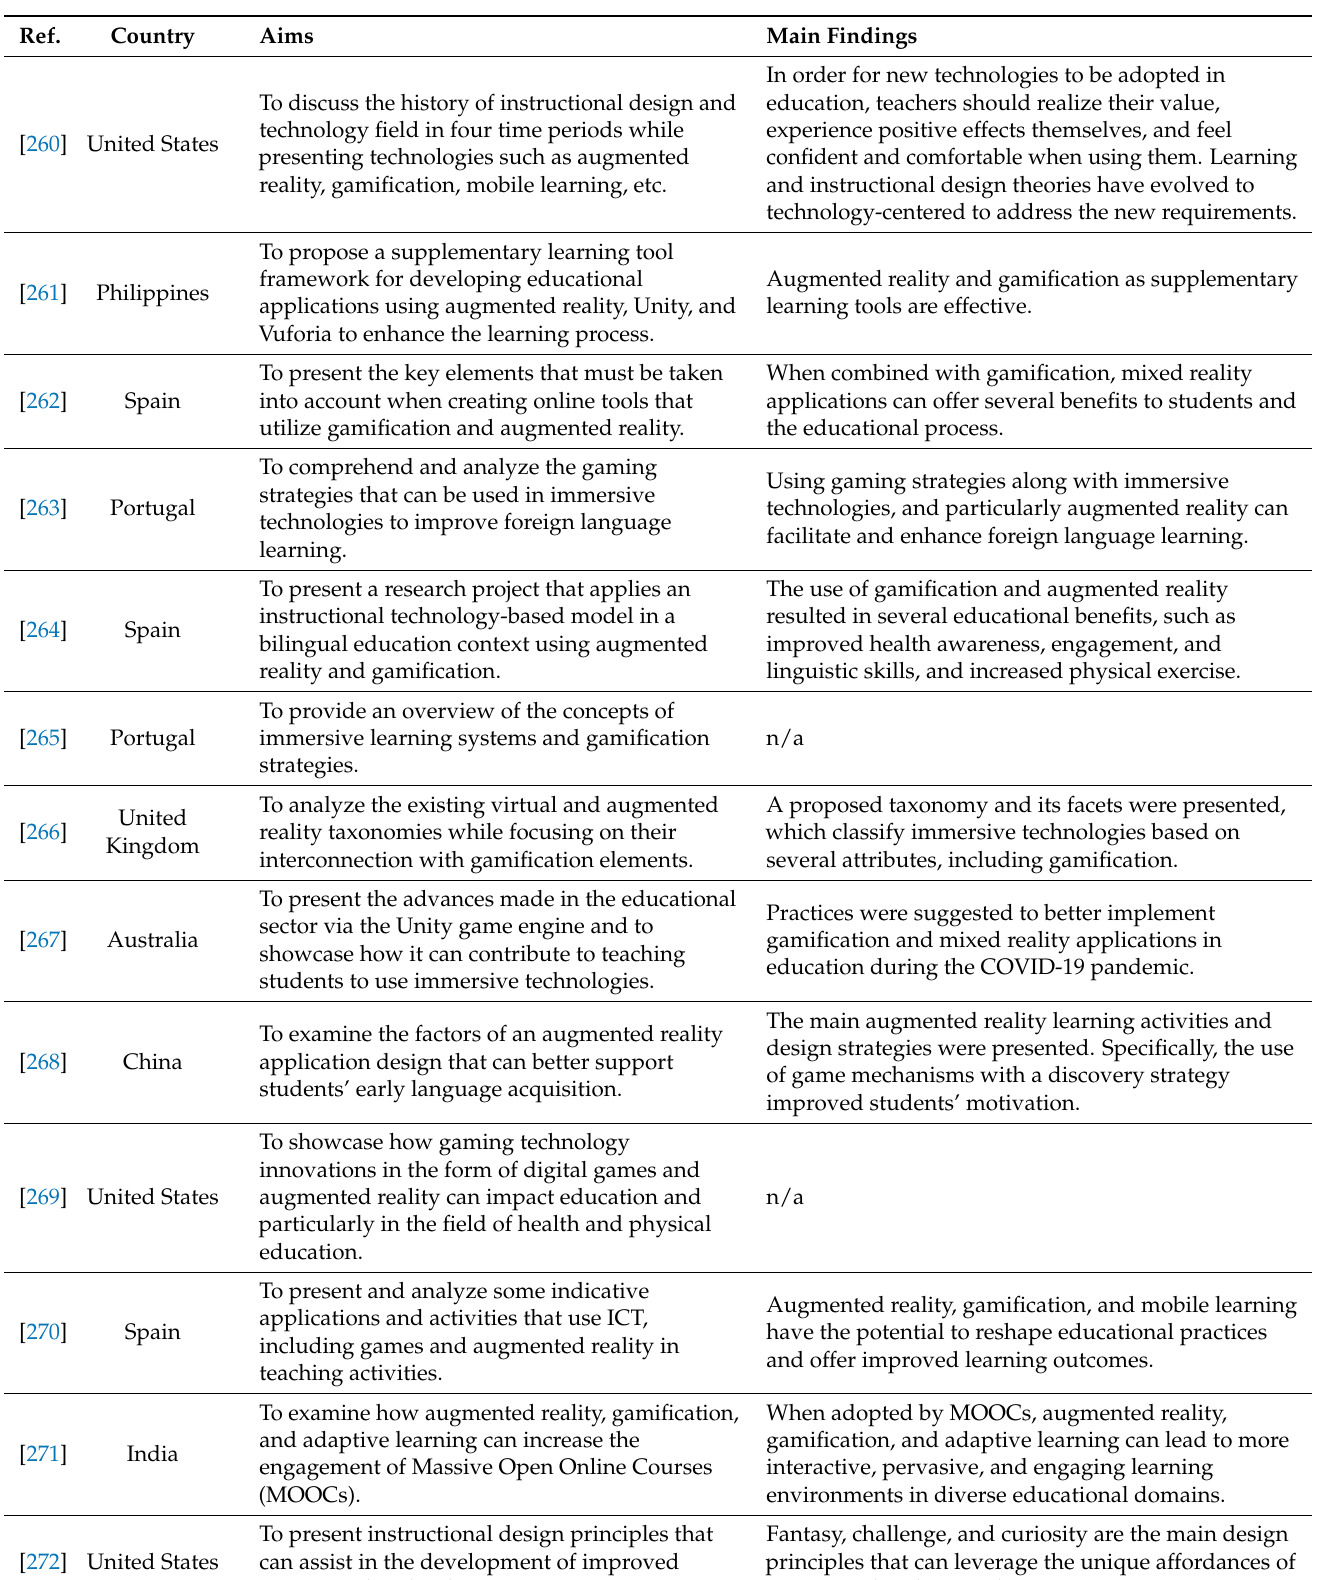
Table 6. Review, conceptual, and theoretical papers: general